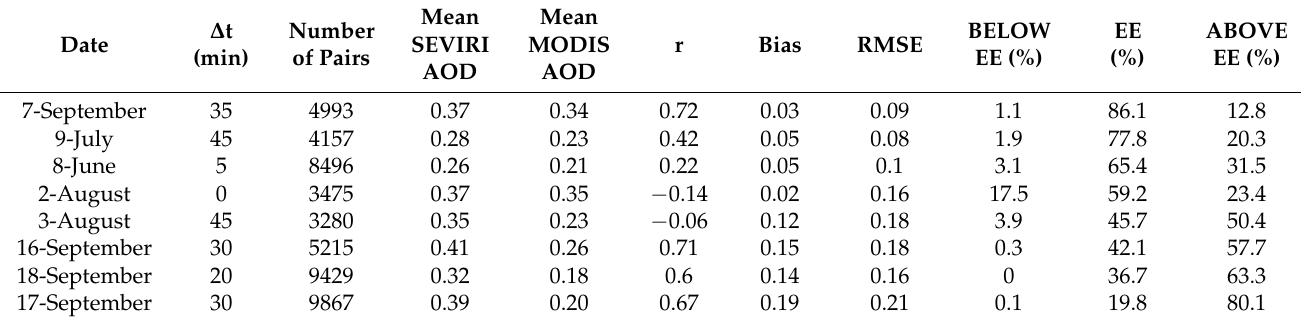
Table 7. Statistics: SEVIRI AOD vs. MODIS